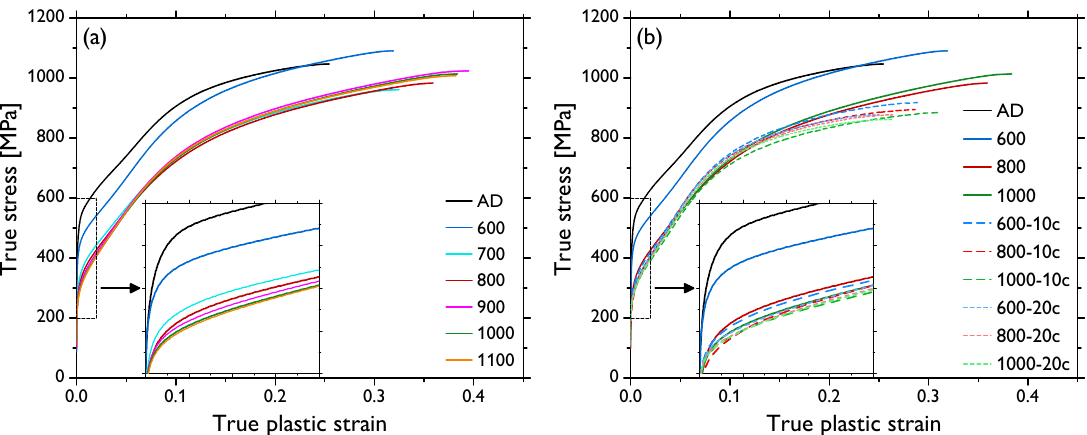
Figure 3. Deformation curves of the selected samples: ( a ) AD sample and samples 600–1000, ( b ) AD sample and samples 600, 800, and 1000 (for the sake of comparison), samples 600-10c, 800-10c, 1000-10c, and samples 600-20c, 800-20c,